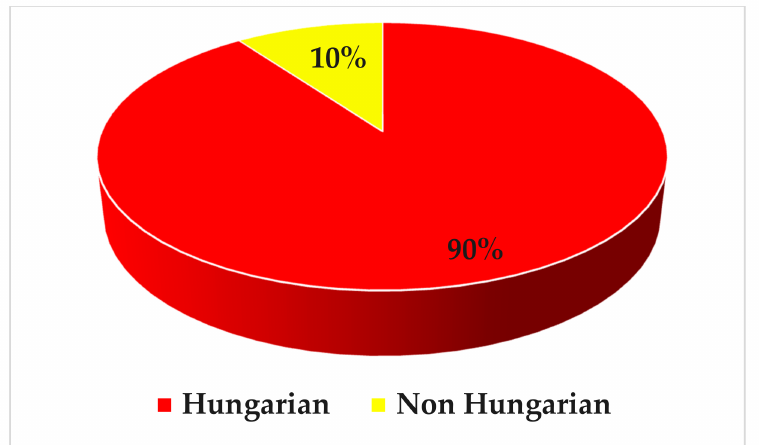
Figure 11. Characteristics of respondents based on